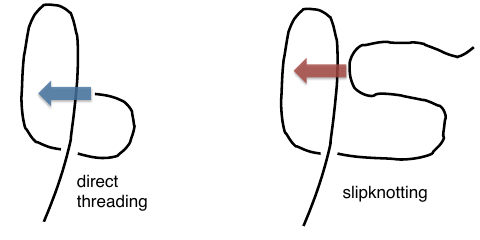
Figure 1. Sketch of common knotting mechanisms in polymers: direct threading and slipknotting.